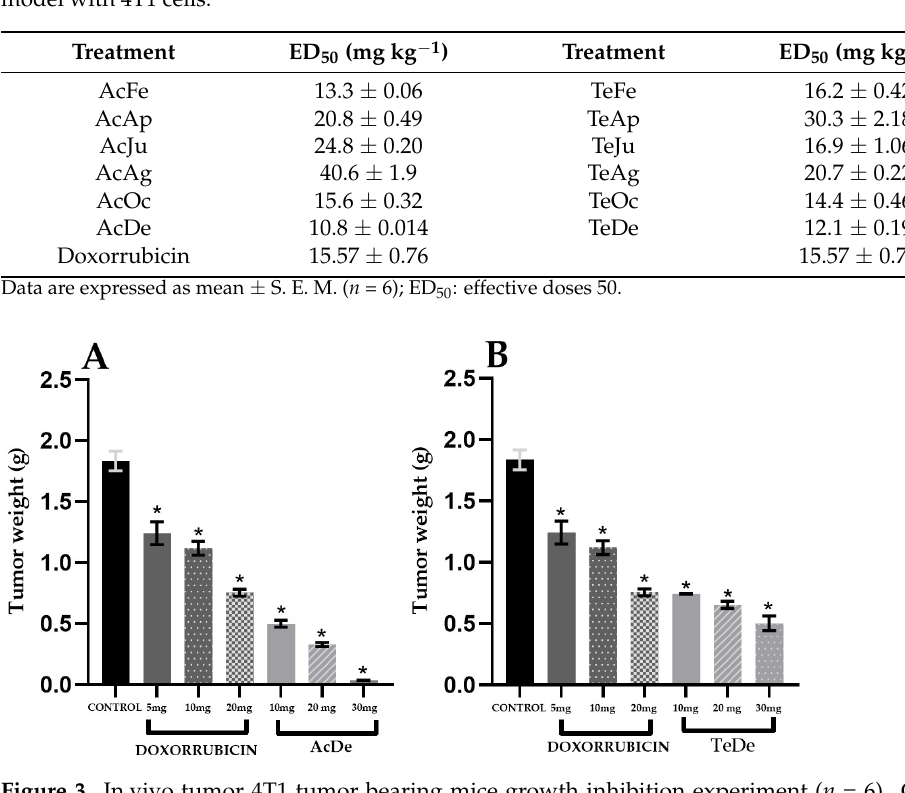
Figure 3. In vivo tumor 4T1 tumor bearing mice growth inhibition experiment ( n = 6). Control: tumor weight harvested from untreated group (control), Doxorubicin: pharmacological control. ( A ) Tumor weight of group treated with different doses of AcDe; ( B ) Tumor weight of group treated with different doses of TeDe. Each value represents the mean ± standard error of the mean. * p < 0.05 vs. Control group.